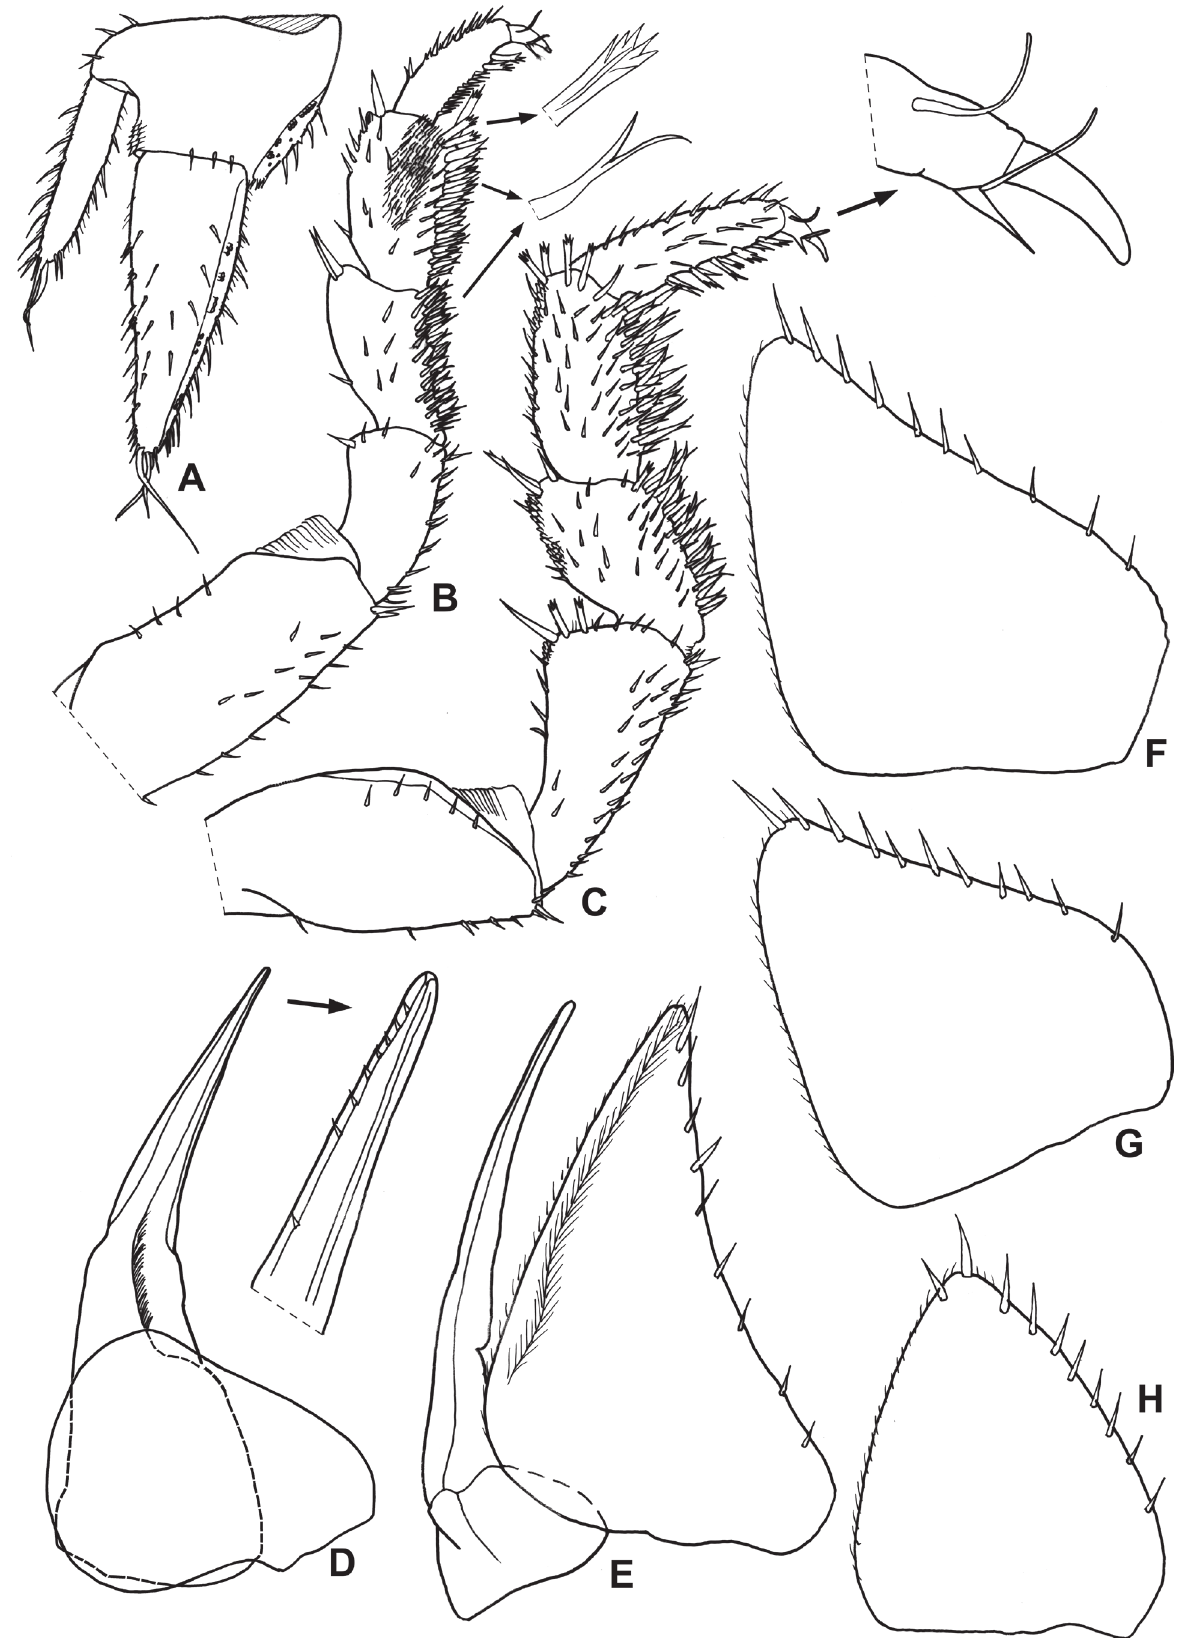
Figure 13. Trichorhina pataxosi n. sp. (male paratype). A, uropod; B, pereopod 1; C, pereopod 7; D, pleopod 1; E, pleopod 2; F, pleopod 3 exopod; G, pleopod 4 exopod; H, pleopod 5